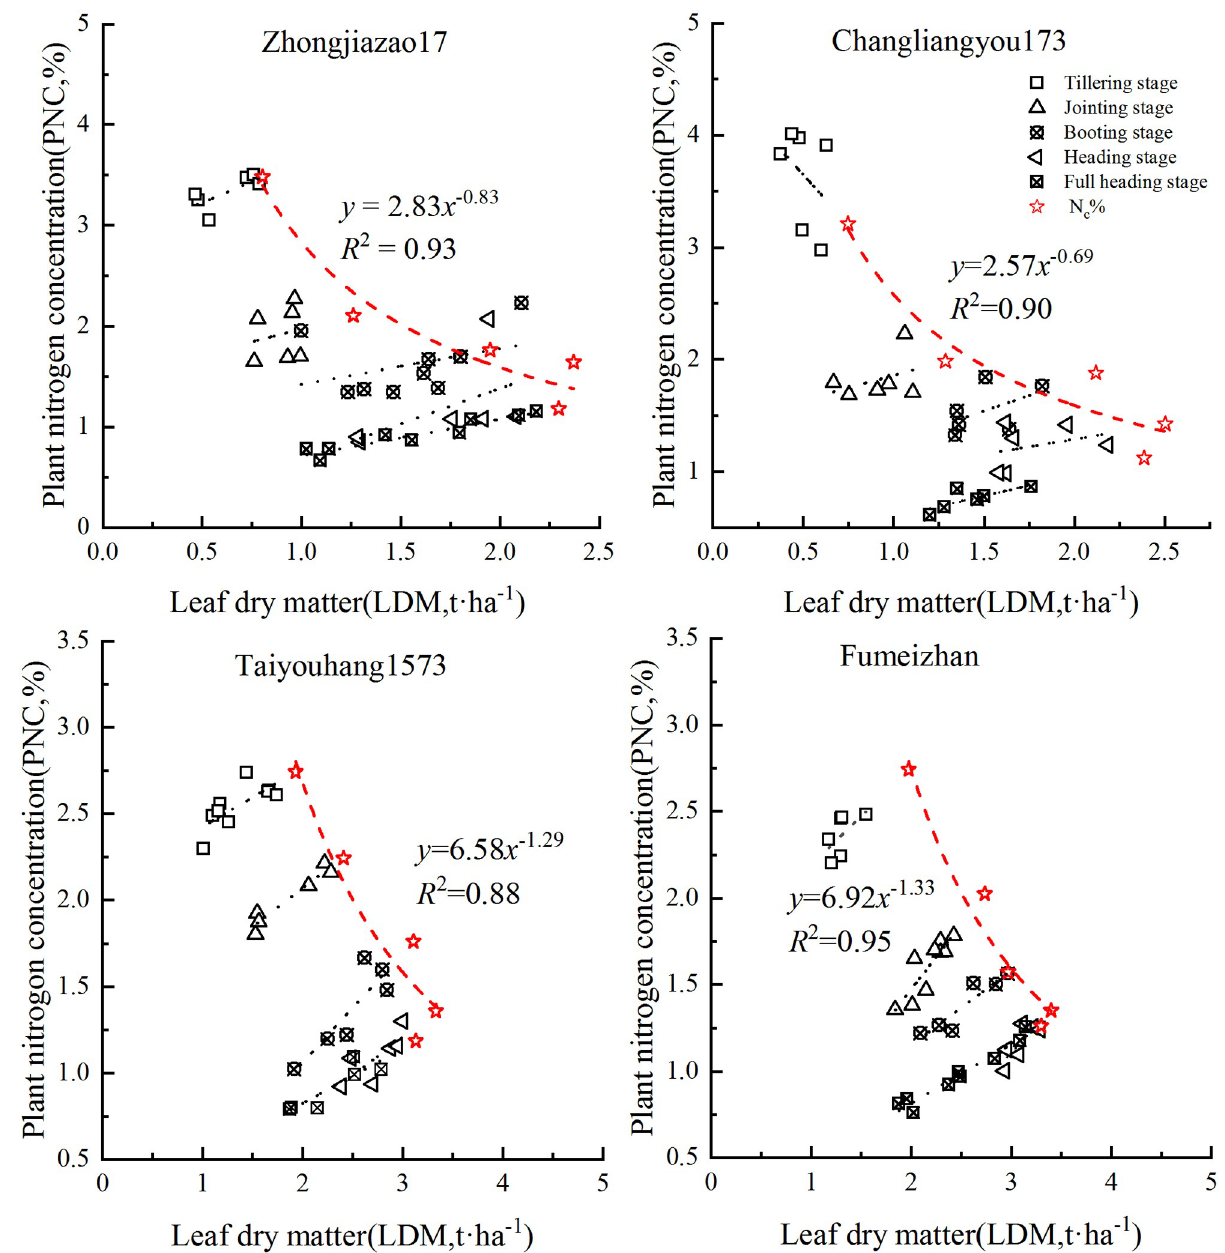
Fig 1. Critical nitrogen concentration dilution curve of rice based on leaf dry matter in